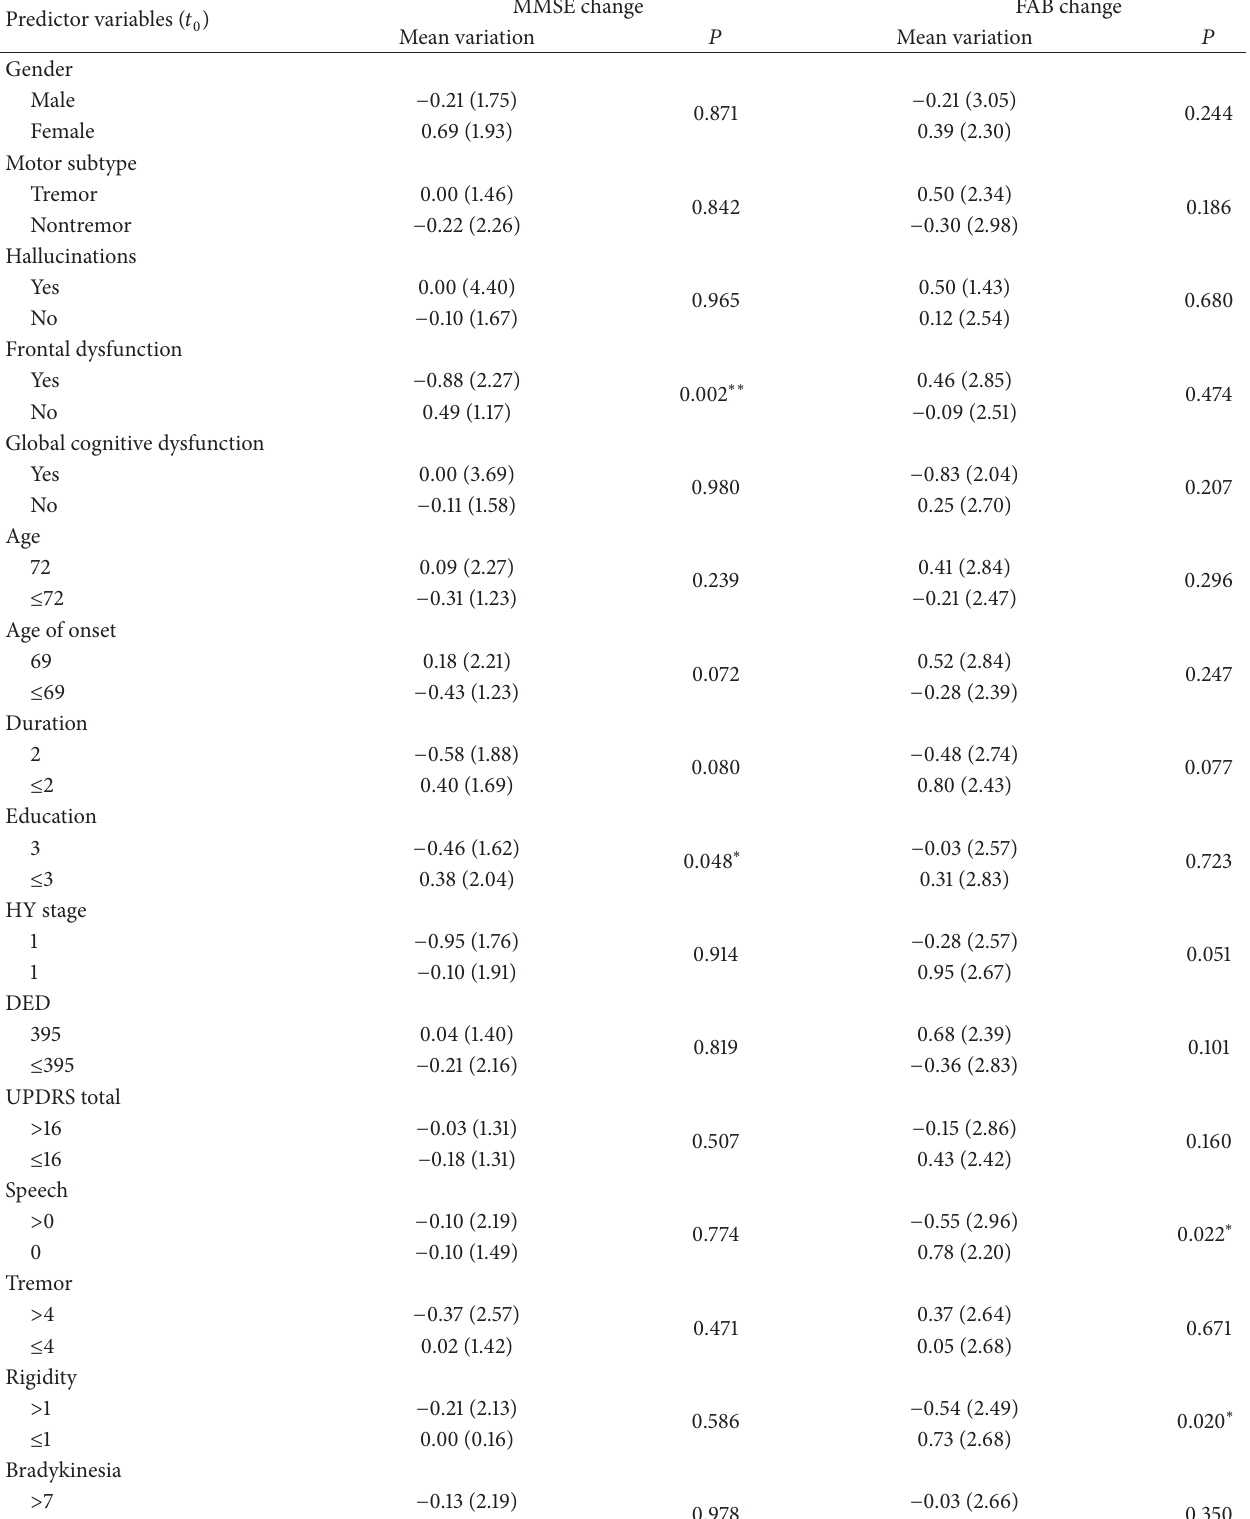
Table 5: Baseline comparisons regarding the MMSE and FAB changes from 𝑡 0 to 𝑡 1